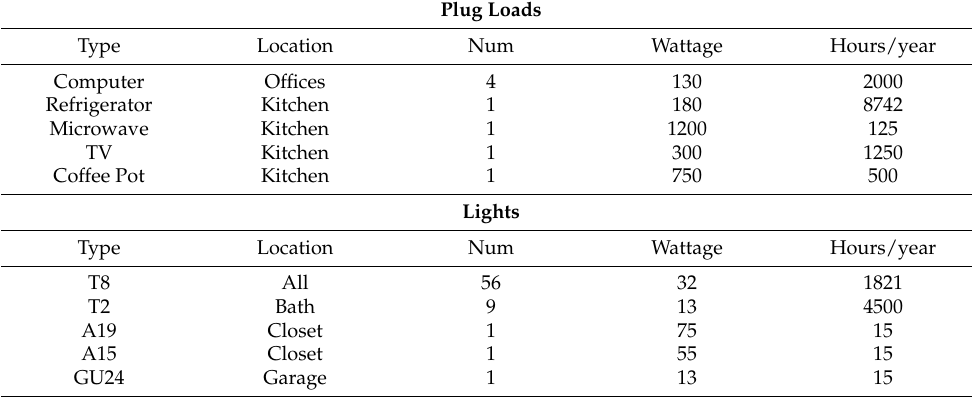
Table 2. Plug loads and